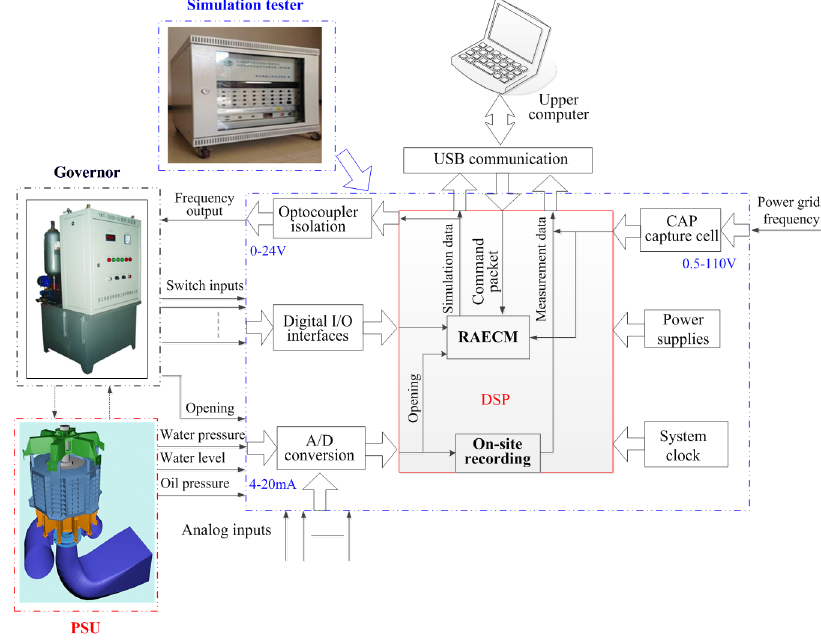
Figure 18. The engineering application of RAECM.